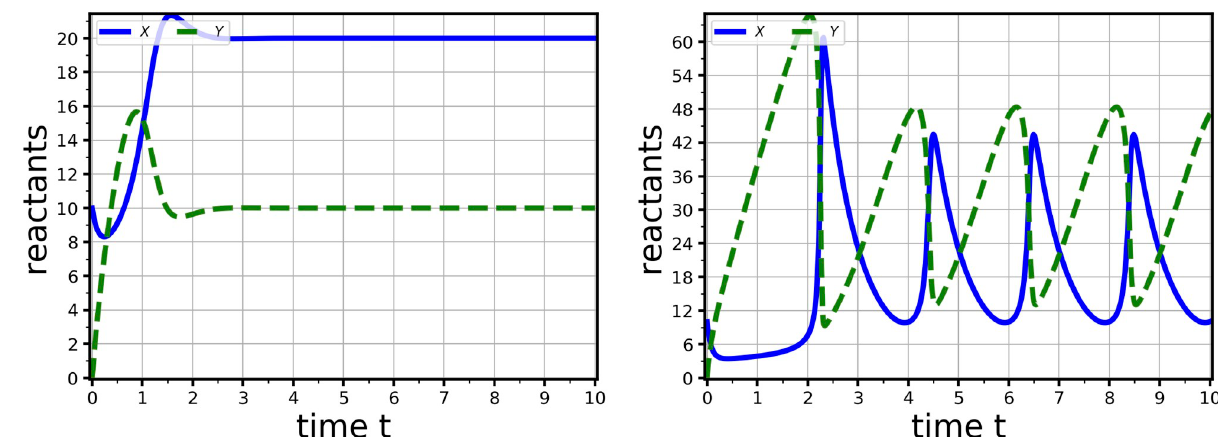
Fig 3. Numerical integration of the Brusselator equations. The Brusselator equations ([3], p.253) exhibit either stable (left) or oscillatory (right) dynamics according to the parameter values selected. Parameter sets: F α = F β = χ = δ = γ = ξ = 2.0, F = 2.0, F β = 5.5, F = 1.0, system size = 10 (right). Xt (0)